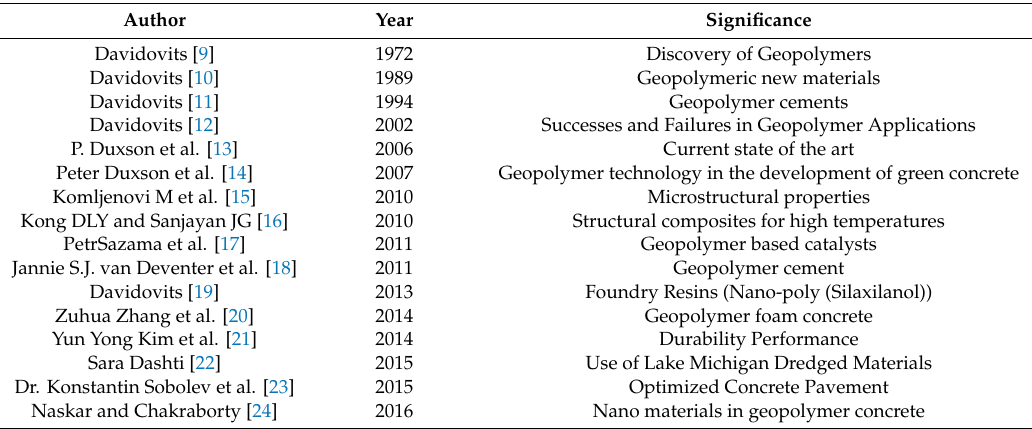
Table 2. Development of geopolymers and their